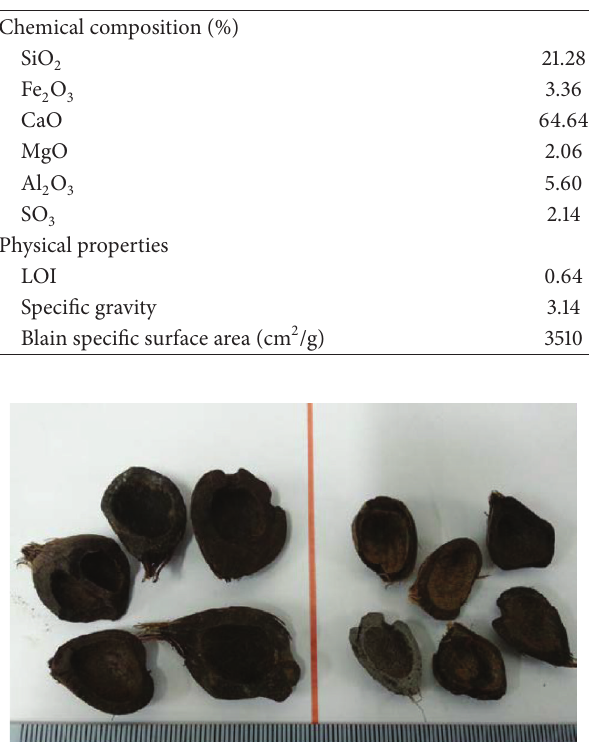
Table 1: Chemical composition and physical properties of OPC.